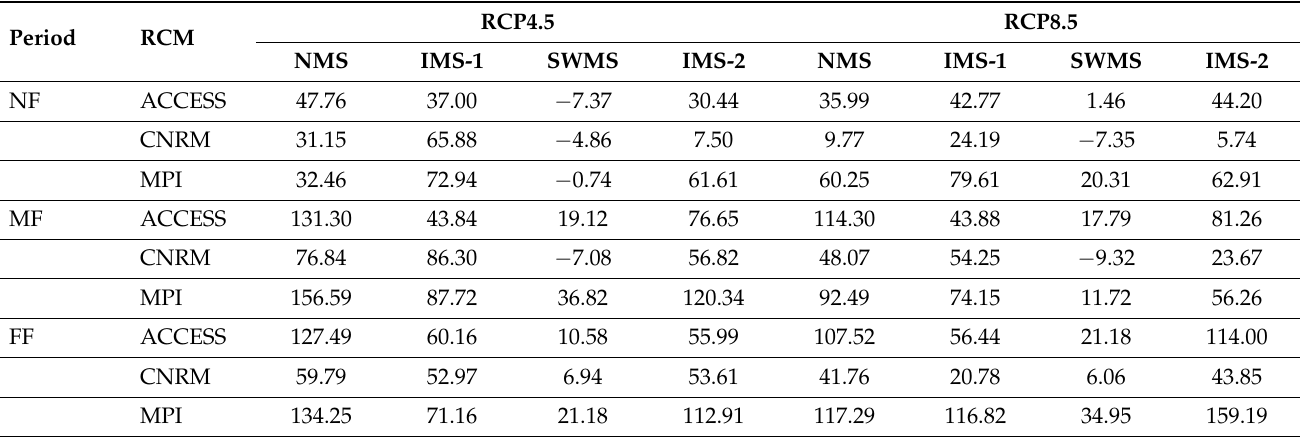
Table 7. Projected mean seasonal changes (%) in streamflow for NF (2015–2042), MF (2043–2070) and FF (2071–2099) at Pitabeddara compared with the baseline period (1998–2014) under RCP4.5 and RCP8.5 scenarios in the UNRB.